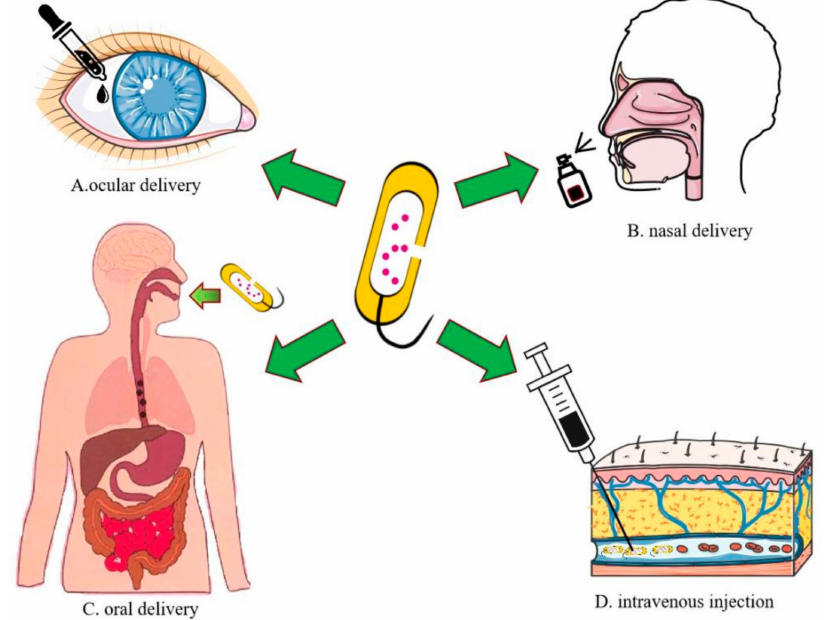
Figure 6. Route of administration of